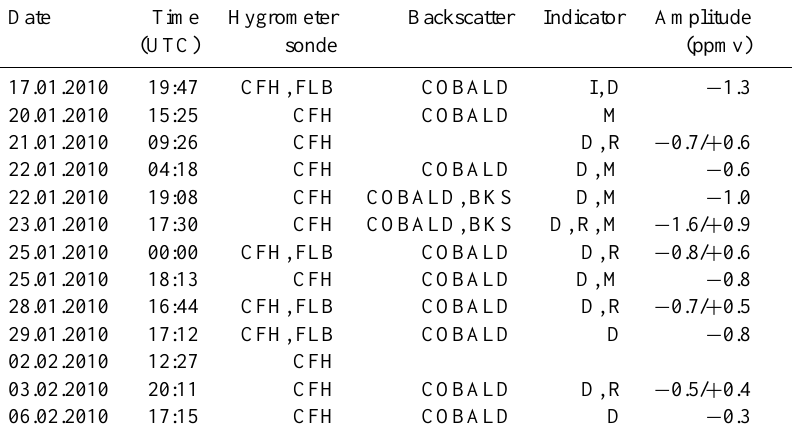
Table 1. Listing of water vapour and aerosol soundings conducted during the first phase of the LAPBIAT-II campaign, January/February 2010, Sodankylä, Finland. The soundings which did not provide useful data in the stratosphere due to technical issues are not listed. From left to right: date and time of the balloon launch; hygrometer type used (FLB = FLASH-B); backscatter sonde used (BKS = Wyoming backscatter sonde); indicator of ice occurrence (I), STS or NAT/liquid mixture clouds (M), dehydration (D) or rehydration (R) signatures (identified as deviation of the vertical profiles from the 10yr January mean profile); maximum amplitude of dehydration or rehydration signal, negative or positive, respectively (in ppmv). All soundings included ECC ozone sondes. Date Time Hygrometer Backscatter Indicator sonde